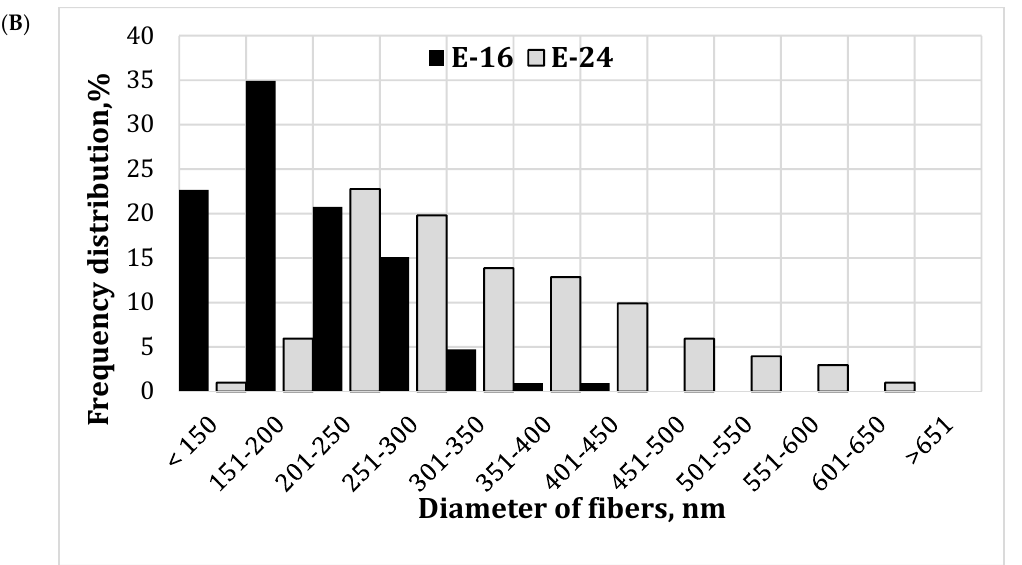
Figure 2. Distribution of electrospun EE100 in OEE fibers, produced from various contents of the EE100 in the OEE, as a function of the fibers diameter (nm): ( A ) E-16, E-24, E-32, and E-40, interval: 400 nm; ( B ) E-16, and E-24, interval: 150 nm.